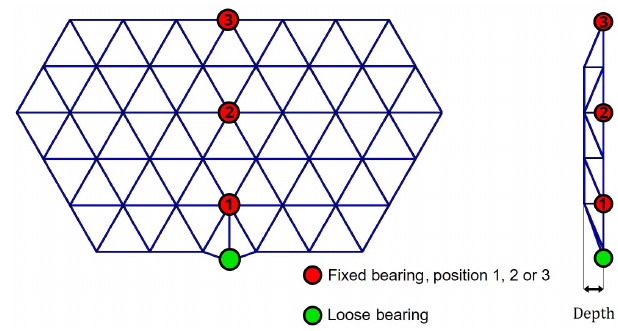
Figure 6. MD-MRS design for 45 rotors based on Jamieson et al.